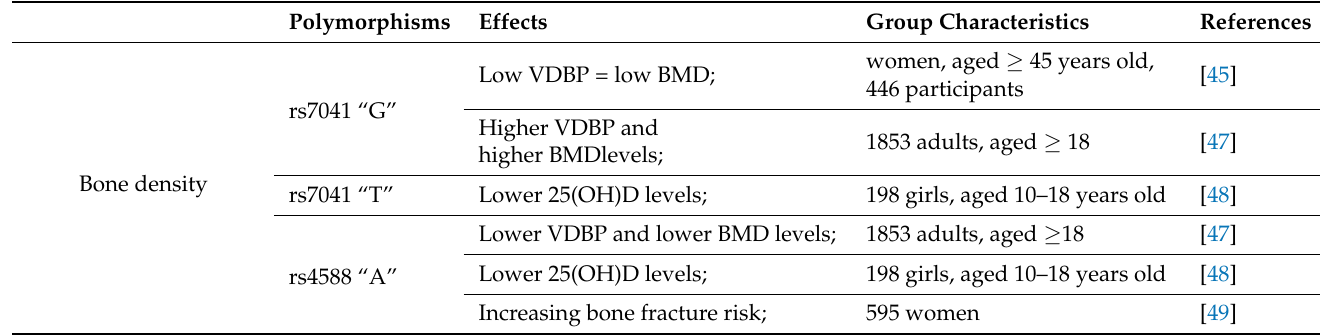
Table 4. Summary of mentioned diseases in the Section 2. Most common VDBP polymorphisms with